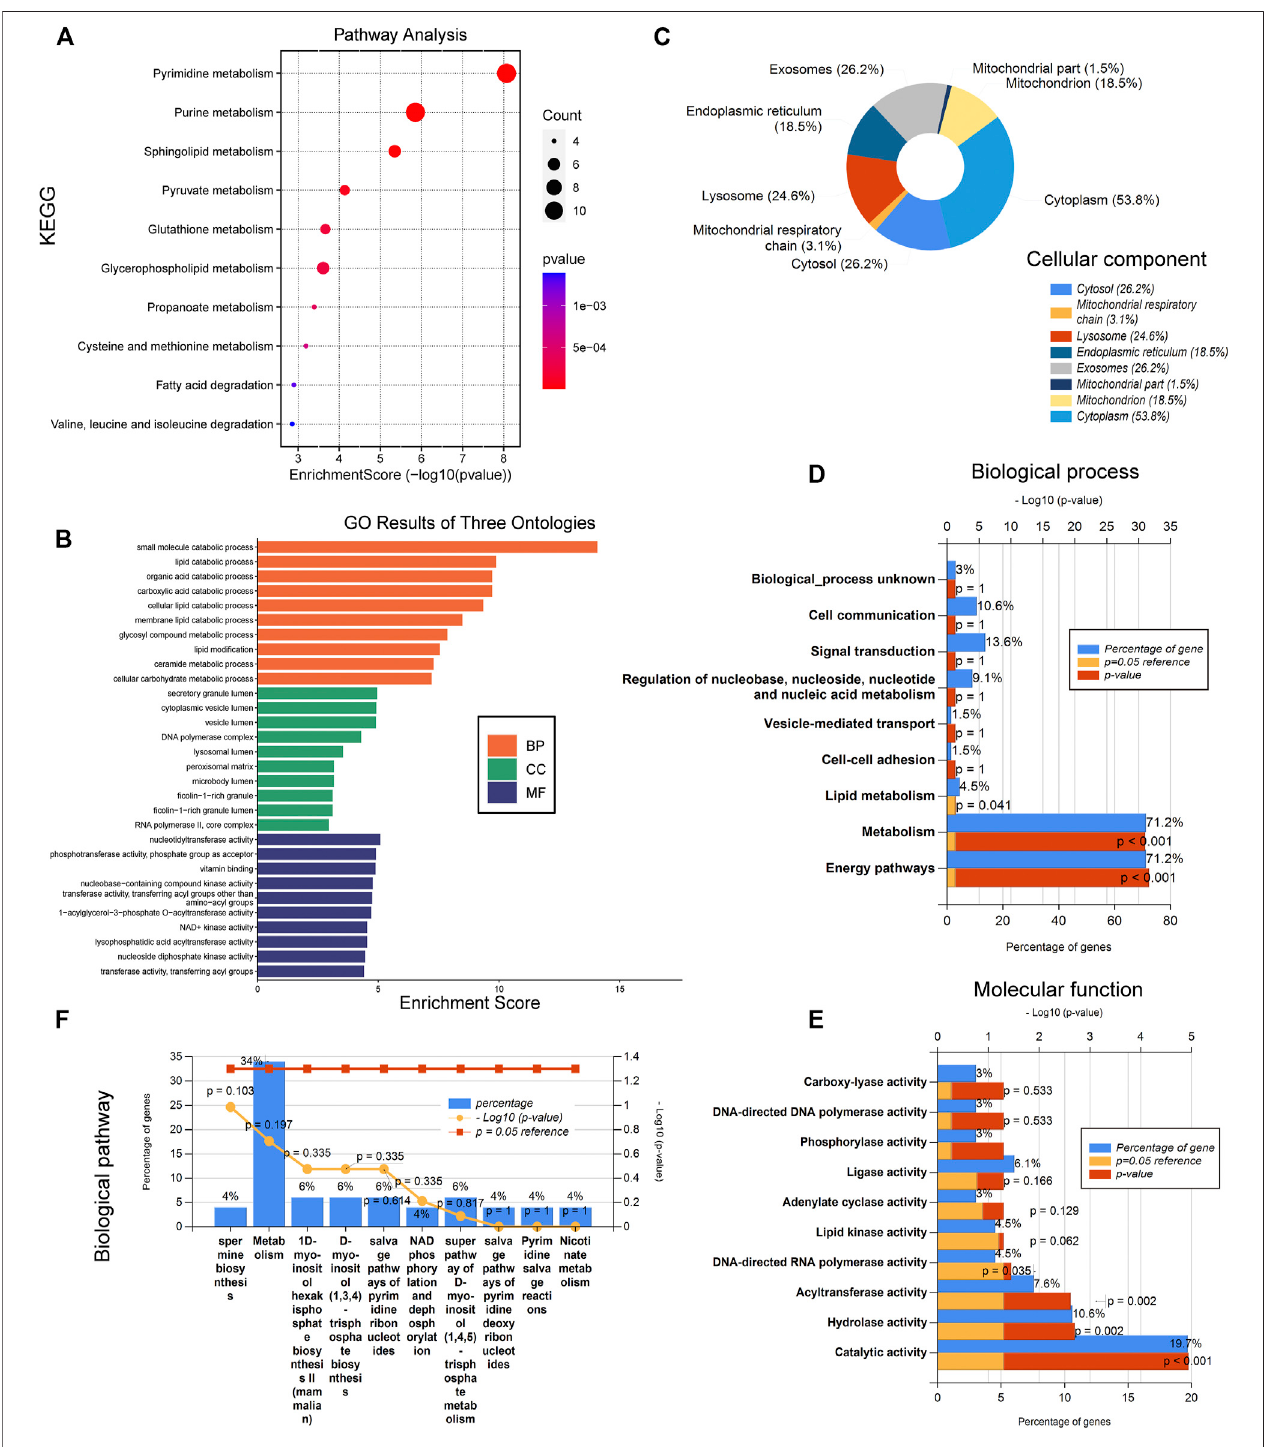
FIGURE 2 | Metabolism-related pathways are involved in the pathophysiology of sepsis. (A) Kyoto Encyclopedia of Genes and Genomes (KEGG). (B) Gene ontology (GO) results of biological process (BP), cellular component (CC), and molecular function (MF). (C) Cellular component (CC). (D) Molecular function (MF). (E) Biological process (BP). (F) Biological pathway.